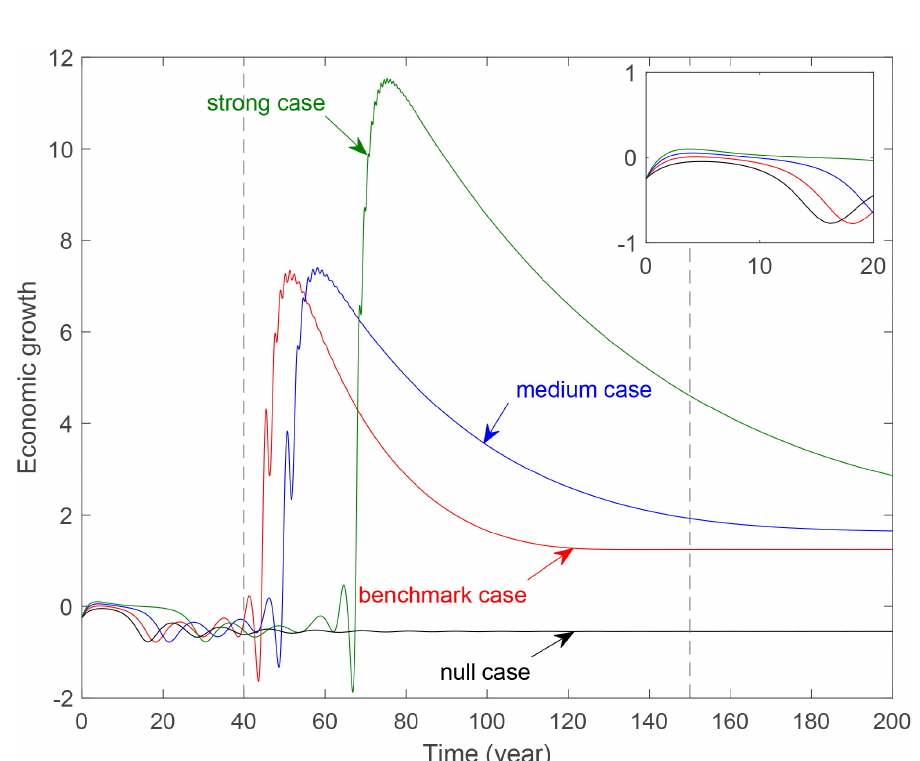
Fig 8. Evolution of economic growth with different government control parameter b 4 . Benchmark case : b 4 = 0.2488. Medium case : b 4 = 0.4488. Strong case : b 4 = 0.6488. The vertical dotted lines separate the evolution period into three time periods. The sub-figure in the upper-right corner is a partially enlarged view. The figures after this have the same meanings as this figure .